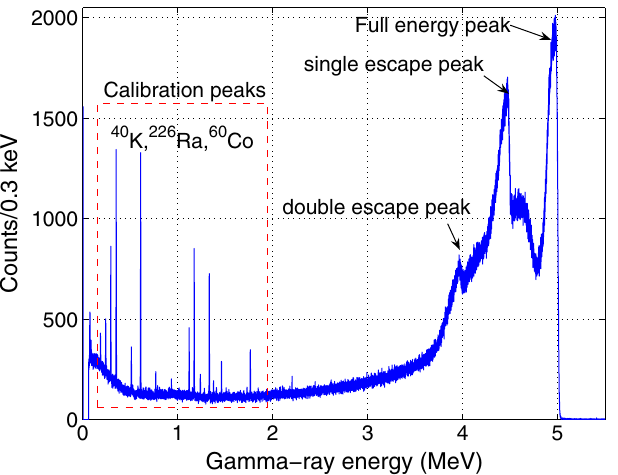
FIG. 10. (Color) High energy edges of the measured HI (cid:1) S beam spectra for different storage ring set energy which is increased from 461.06 to 461.14 MeV with increments of 0.02 MeV per step. The inset is the magnified plot around the gamma-ray energy of 5.005 MeV.